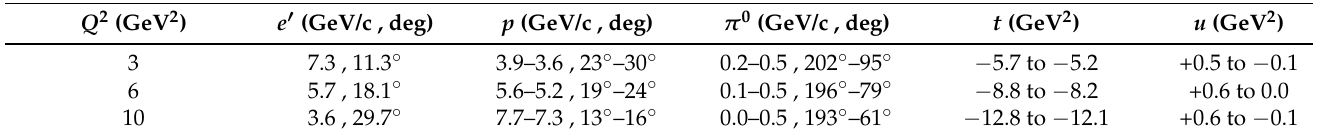
Table 1. Possible kinematics for a backward angle color transparency experiment in Hall C of Jefferson Laboratory. The approximate momentum and the angle of the detected scattered electron and proton, and the undetected π 0 are shown along with the expected t , u ranges covered by the data. See text for